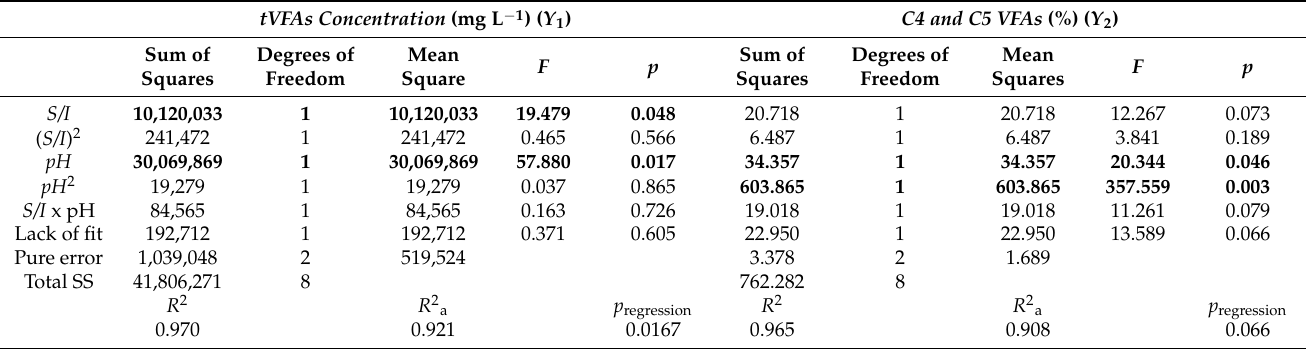
Table 3. Analysis of variance (ANOVA) for the dependent variables evaluated in the Doehlert experimental design.